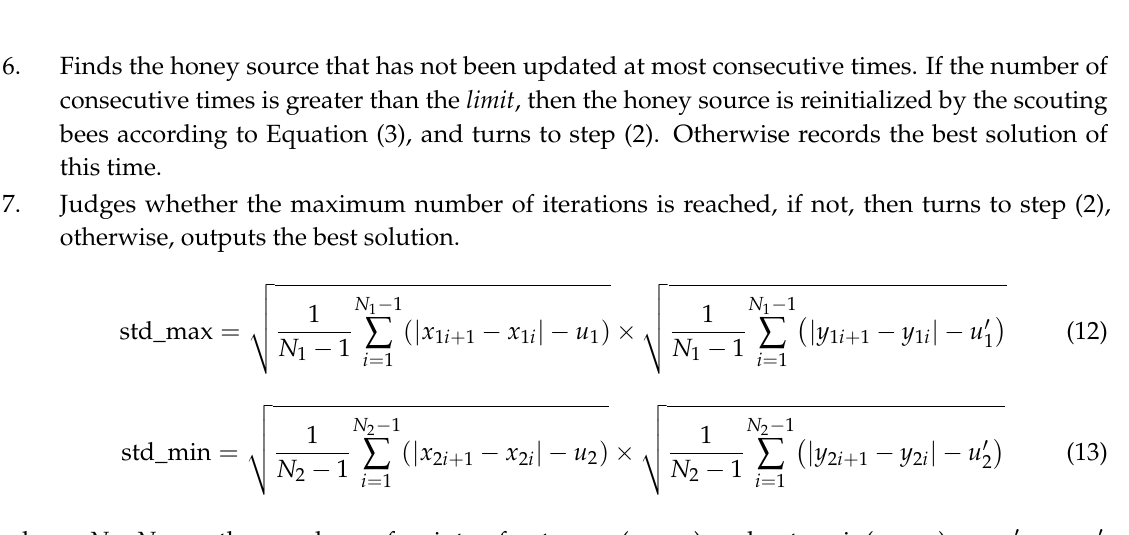
Figure 4. The Fourier transform spectrum of the IMF component with the maximum kurtosis.